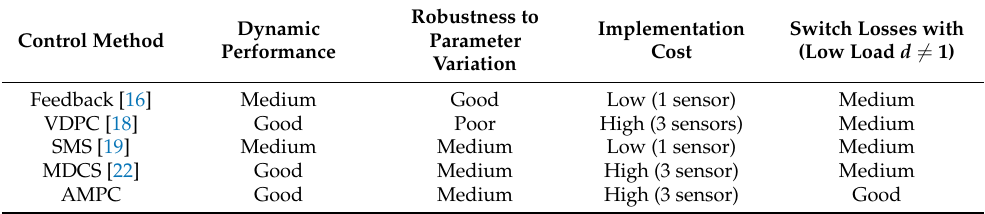
Table 6. Comparison of DAB control